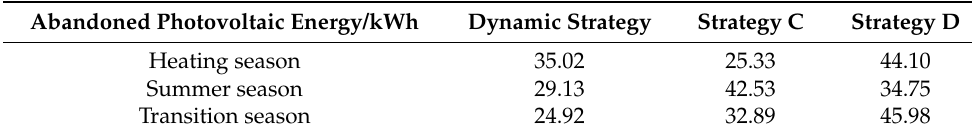
Table 8. Abandoned photovoltaic energy during typical weeks. Abandoned Photovoltaic